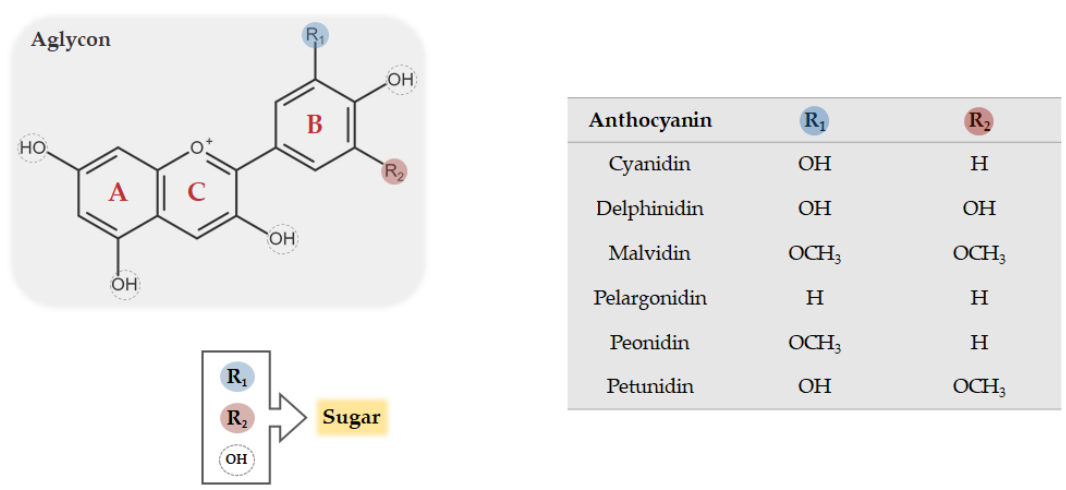
Figure 1. Chemical structure of common anthocyanins. The glycosidic form of anthocyanins is constituted by an aglycon, known as anthocyanidin, bounded to one or more sugar conjugates which may replace both R and OH groups.